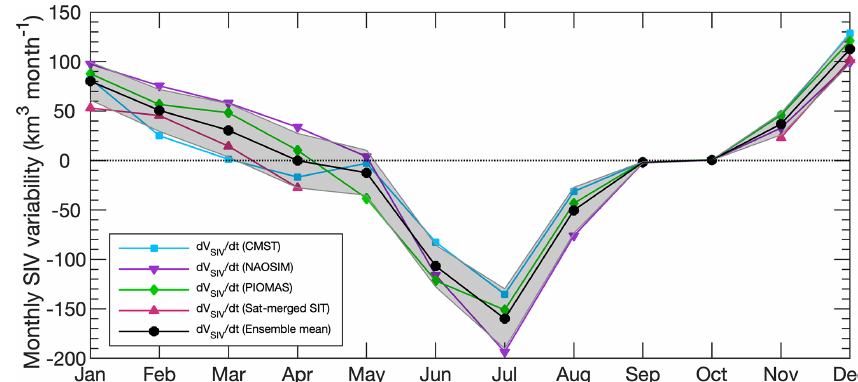
Figure 6. The sea-ice volume changes from CMST (d V SIV / d t (CMST), cyan line), NAOSIM (d V SIV / d t (NAOSIM), purple line), PIOMAS (d V SIV / d t (PIOMAS), green line), satellite observation (d V SIV / d t (Sat-merged SIT), violet red line) and the ensemble mean (d V SIV / d t (Ensemble mean), black line) in the Baffin Bay area. The shading indicates the ensemble spread (1 standard deviation).